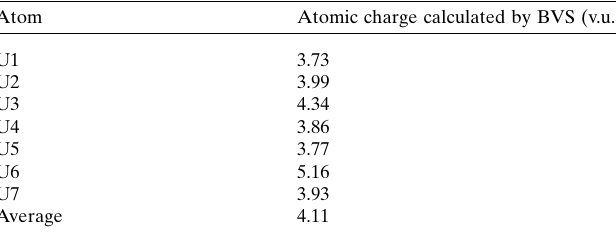
Table 1 Summary of bond-valence-sum (BVS) calculations on the uranium atoms U1–U7 in (I). Atom Atomic charge calculated by BVS (v.u.)